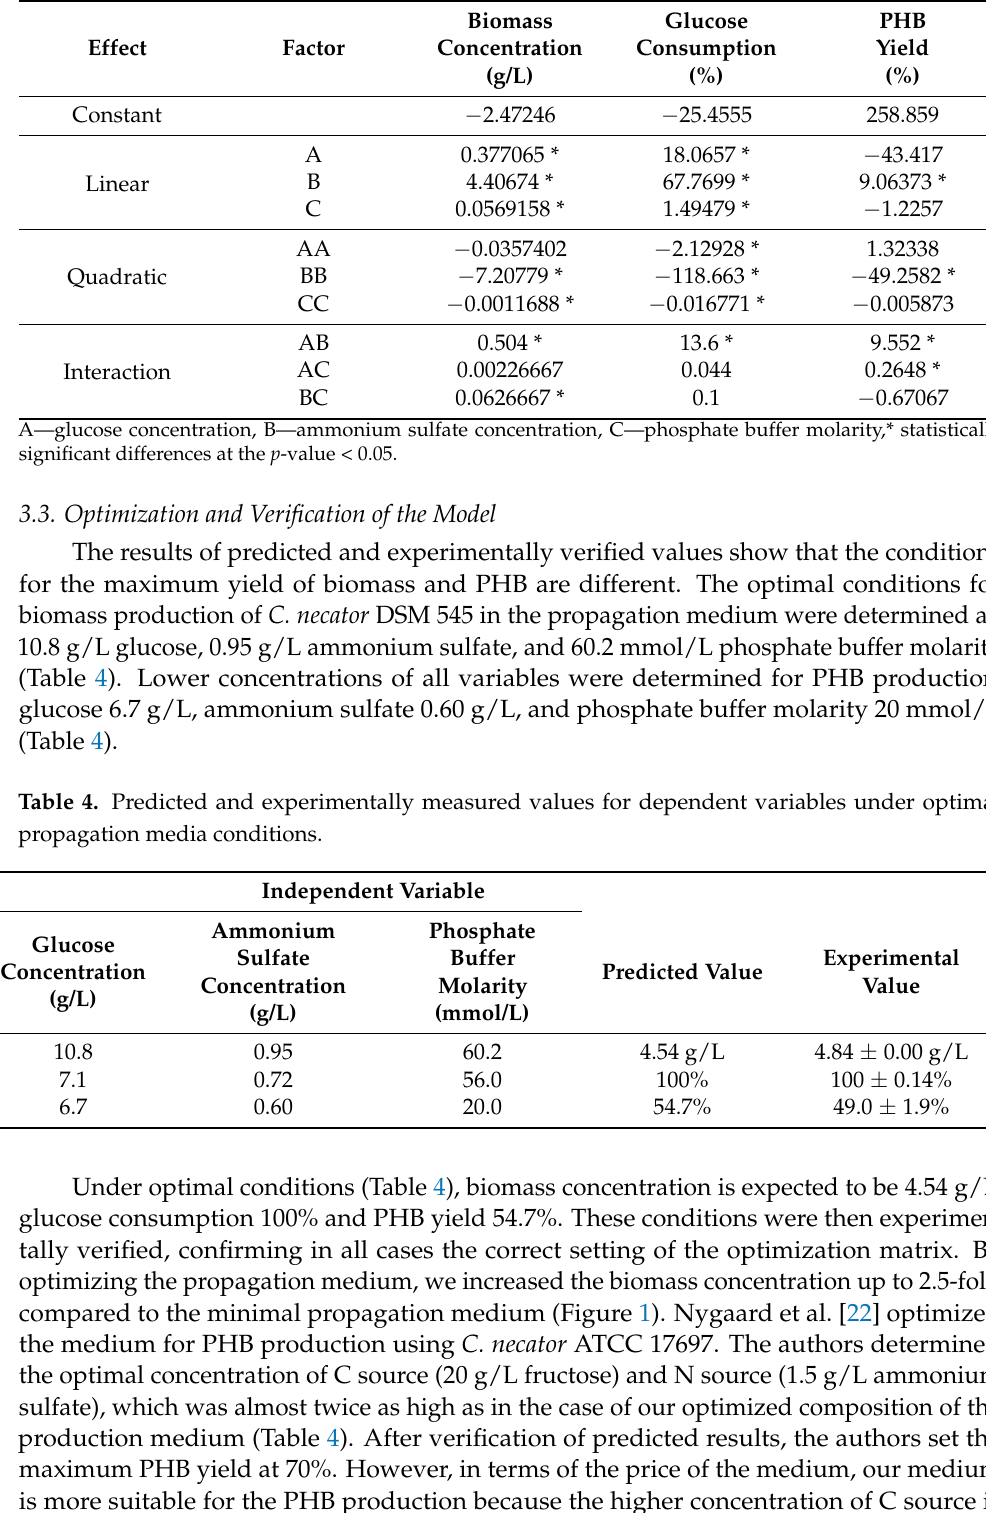
Table 3. Regression coefficients of the hypothesized second-order polynomial model for the depen- dent variables.